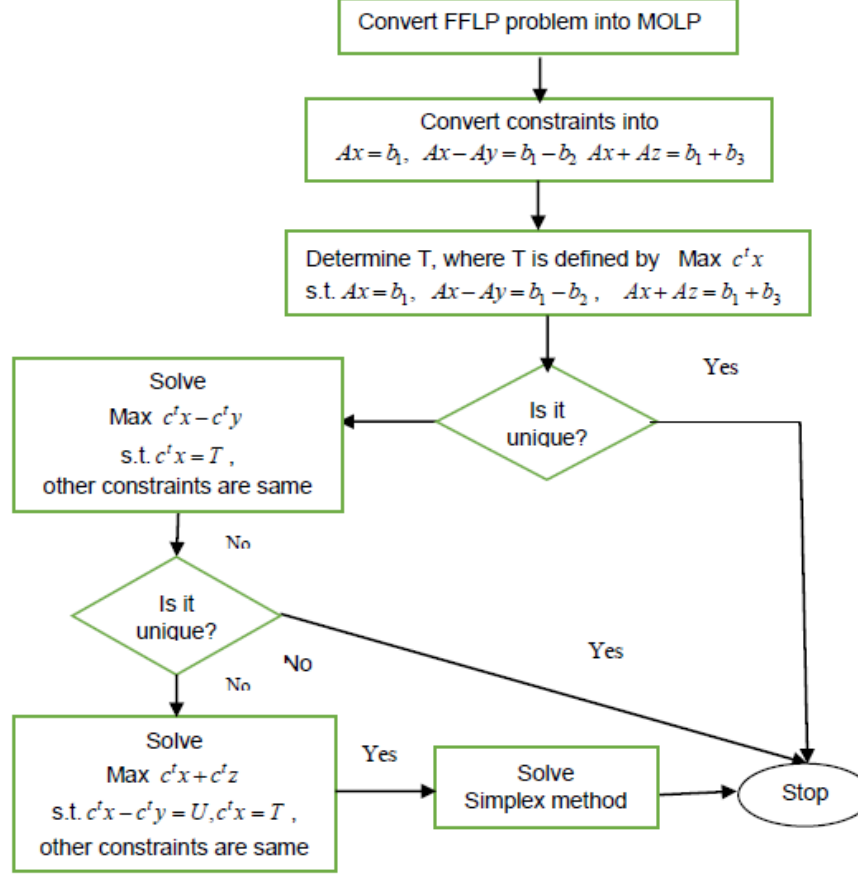
Figure 1. Flowchart for solving FFLP